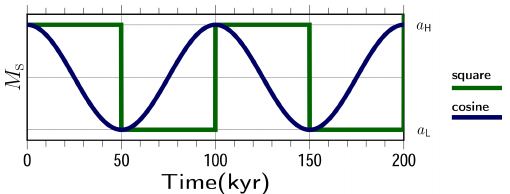
Figure 6. Schematic figure showing the time evolution of the sur- face mass balance adopted in these experiments. Only the first two cycles are